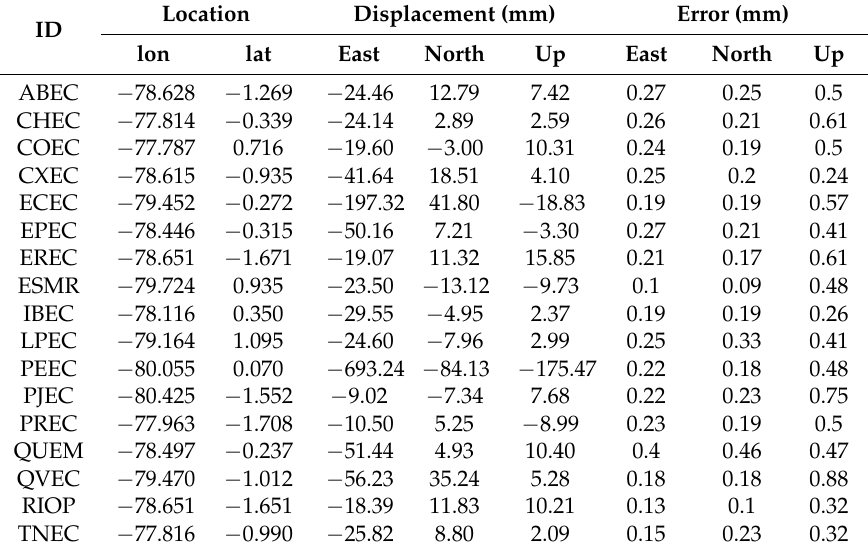
Table 1. Coseismic displacements at the 17 cGPS sites used in this